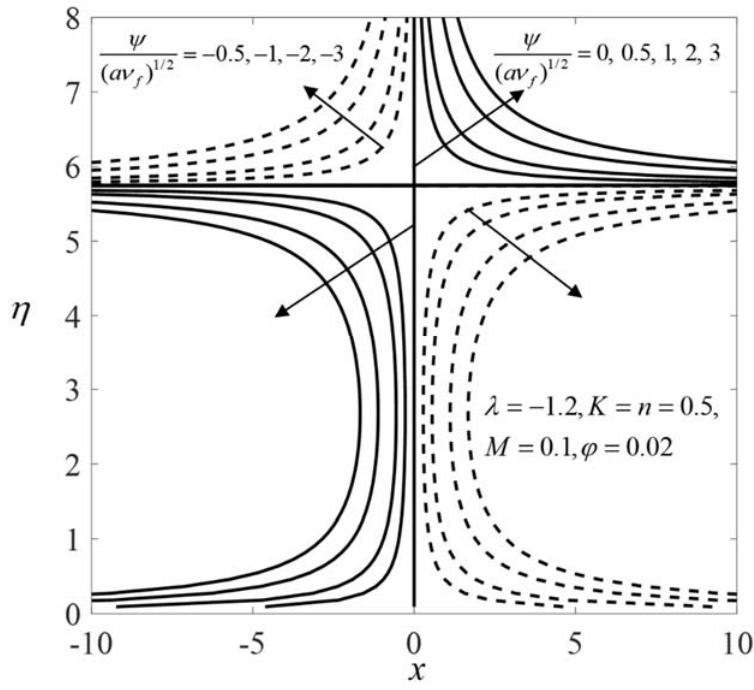
Figure 14. Streamlines when 𝜆 (cid:3407) 0 (shrinking sheet) for the second solution.